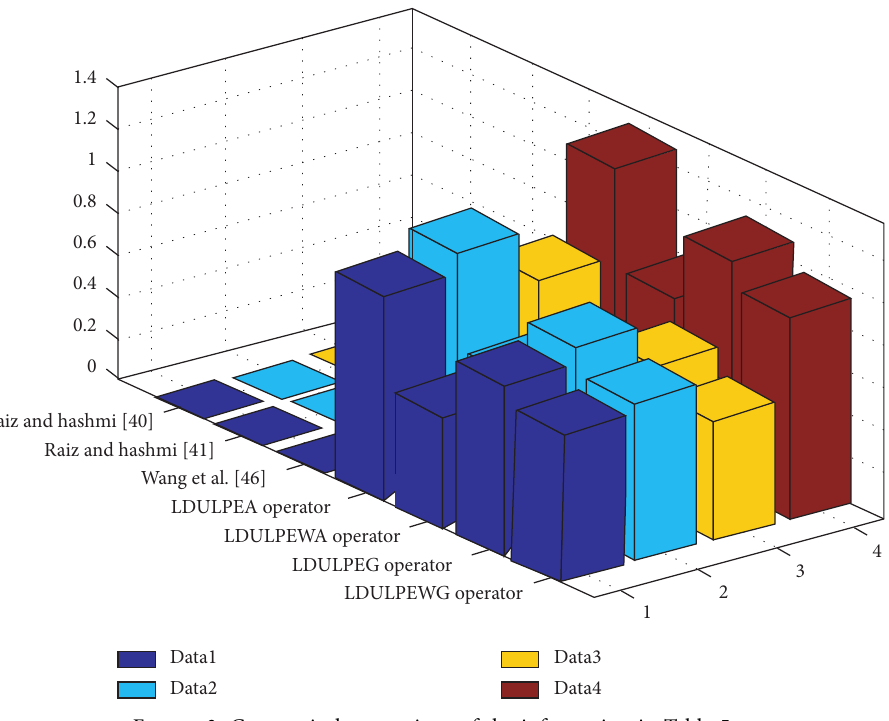
Figure 3: Geometrical expressions of the information in Table 5.